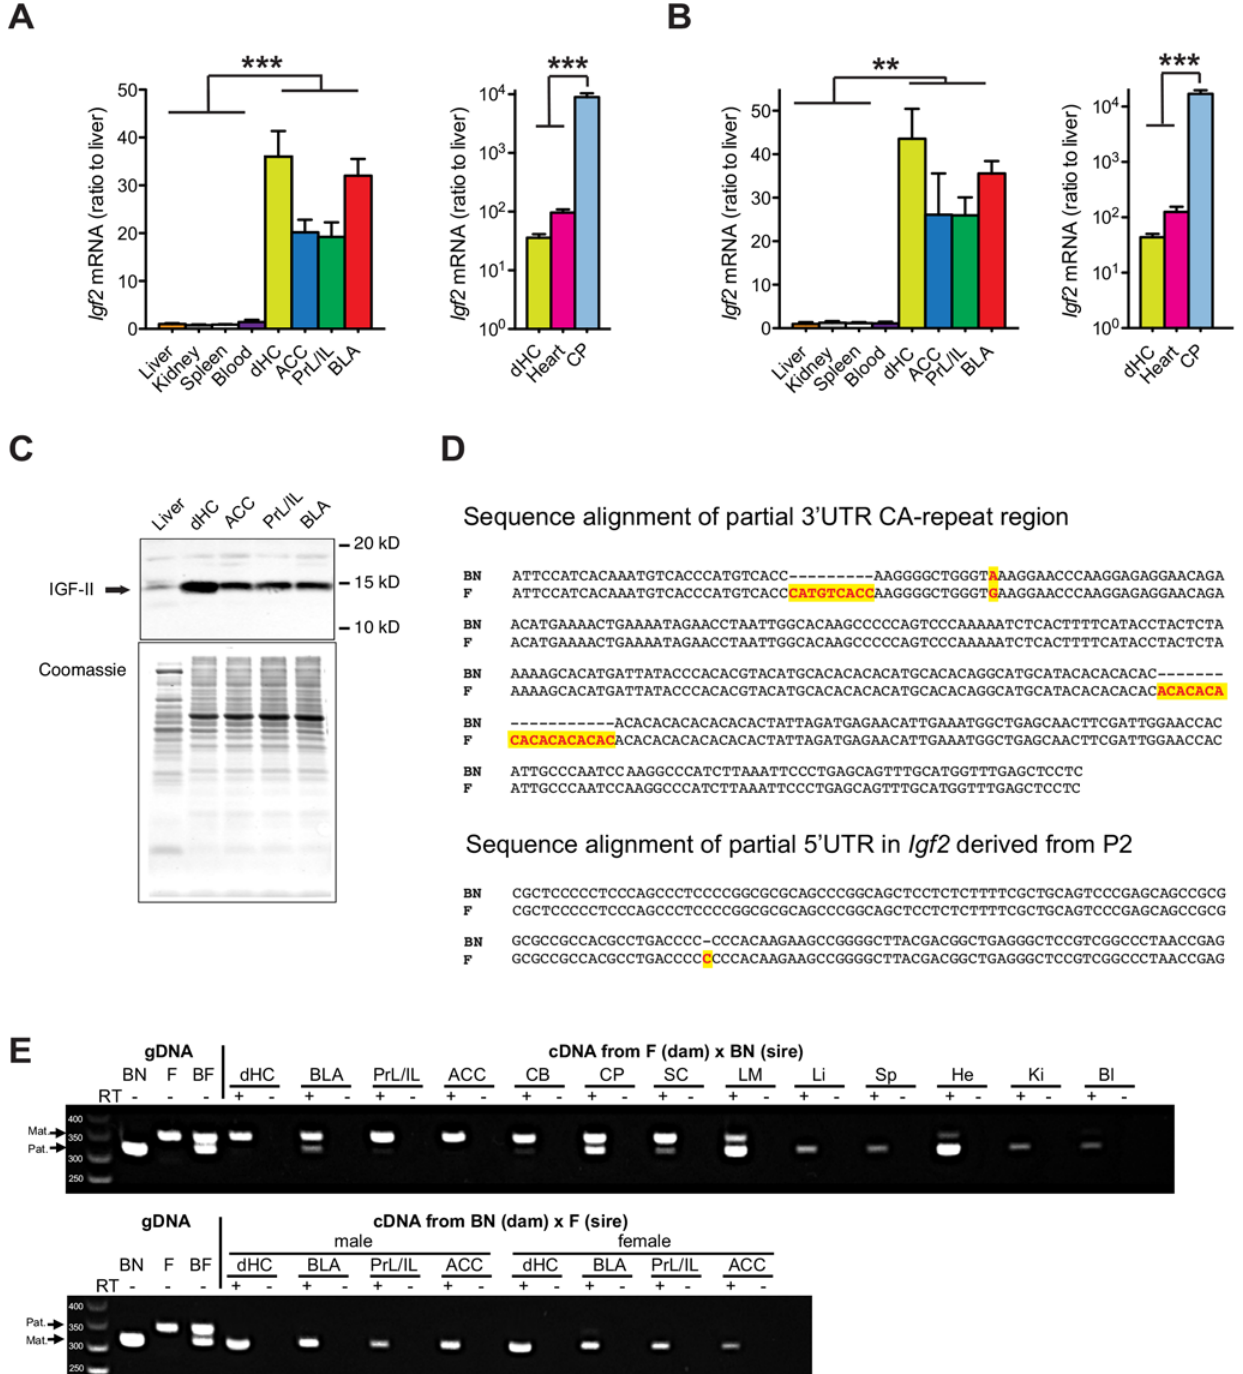
Fig 1. The expression of Igf2 is significantly and dramatically higher in adult rat brain regions compared to peripheral tissues, and is mainly expressed from the maternal allele in the brain and from the paternal allele in peripheral tissues. (A-B) Quantitative real-time PCR analysis of the relative Igf2 mRNA levels in liver, kidney, spleen, blood, heart, dorsal hippocampus (dHC), anterior cingulated cortex (ACC), prelimbic/infralimbic (PrL/IL), basolateral amygdala (BLA) and chorioid plexus (CP) using two independent pairs of primers (n = 3 – 9; for primer set I: F (9, 59) = 39.08, P < 0.0001; for primer set II: F (9, 51) = 103.4, P < 0.0001). In each sample, Igf2 mRNA level was normalized to the 18S RNA level. Data are expressed as mean ± SEM of the ratio of Igf2 mRNA in the liver. ** P < 0.01, *** P < 0.001 (C) Western blot analysis of IGF-2 protein levels in the dHC, ACC, PrL/IL and BLA, compared to that in liver (top panel). A parallel, duplicated gel was used for coomassie staining to reveal protein loading in each sample (bottom panel). This experiment was repeated